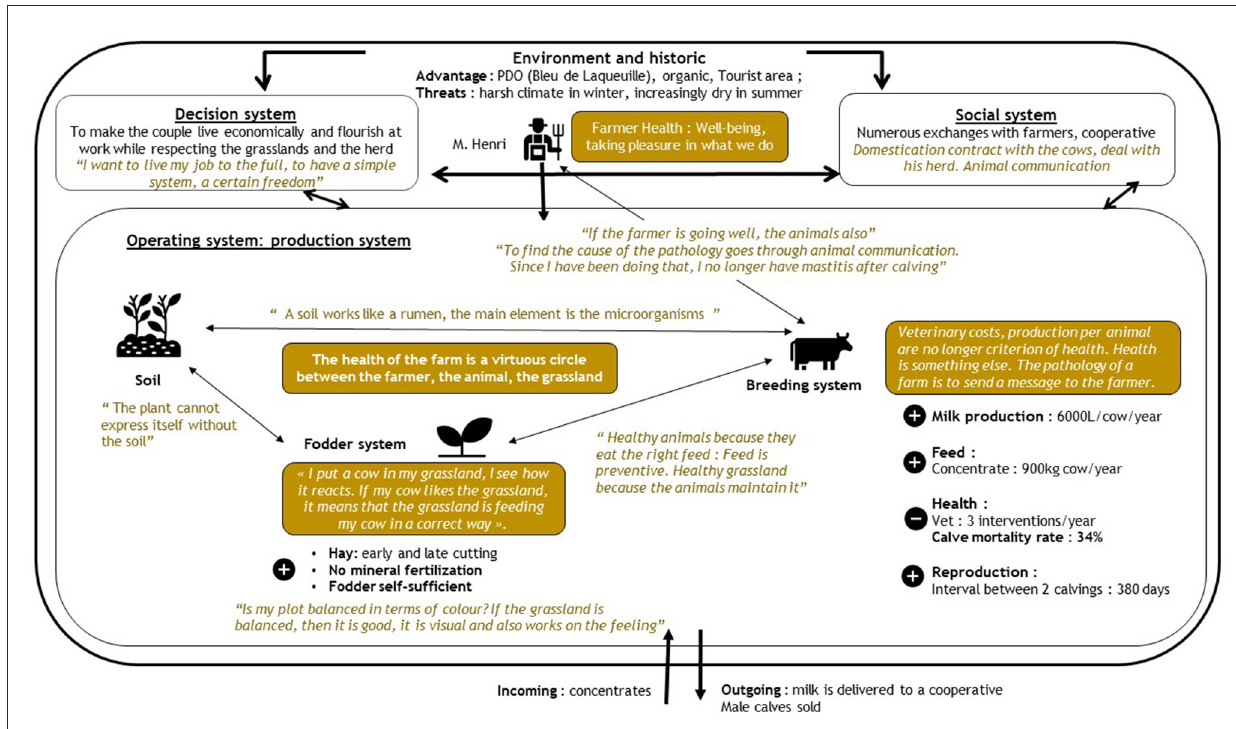
FIGURE2 M. Henri’s farm analysis combining Overall Approach to Farming (in black) and pragmatism posture (in gold).